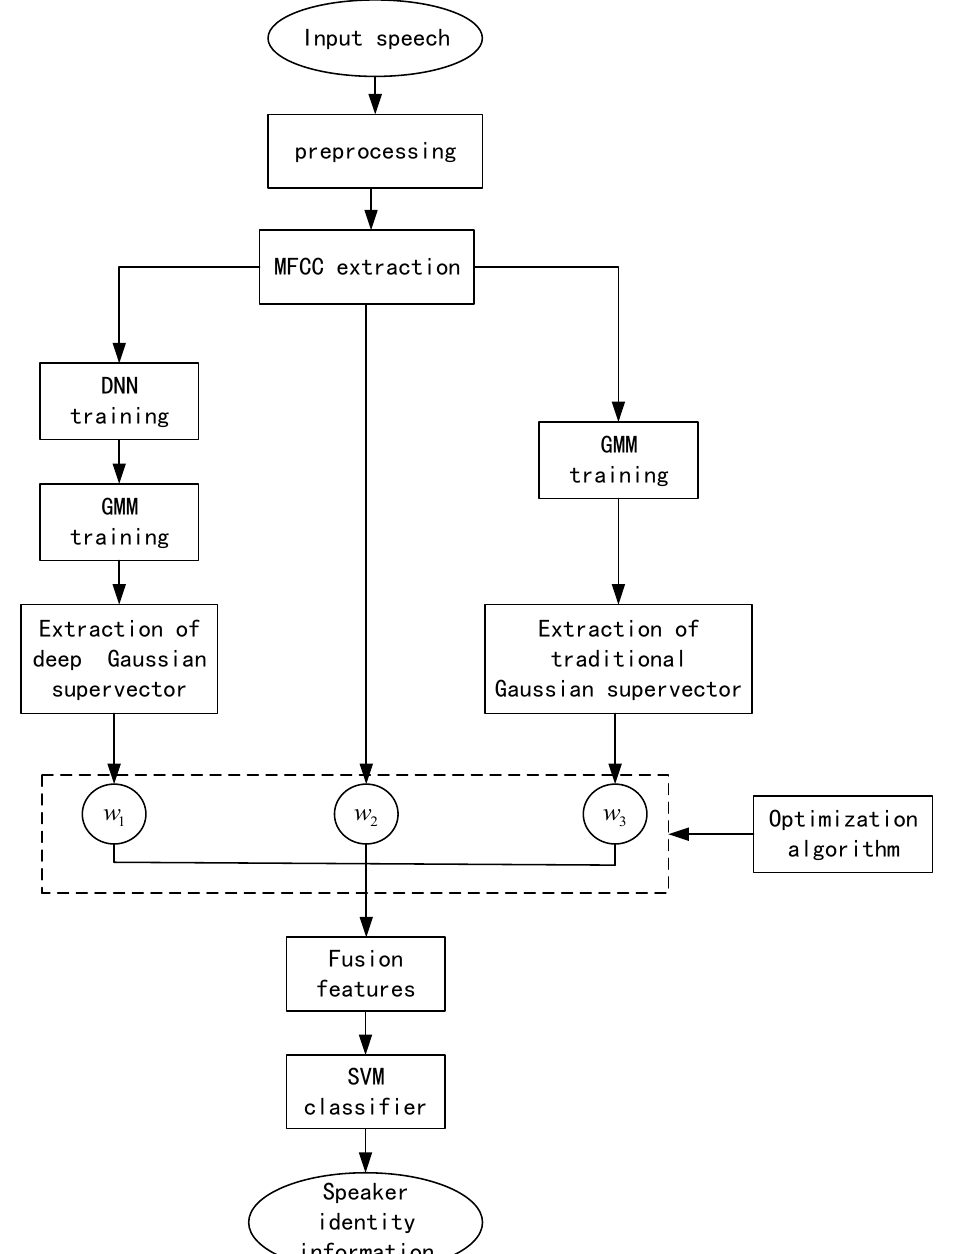
Figure 4. Speaker recognition system based on optimized weight coefficients.